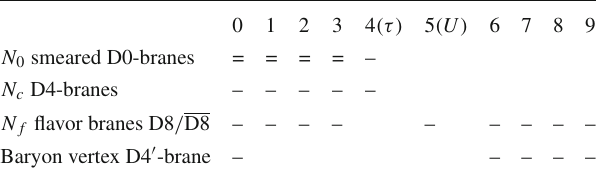
Table 1 The D-brane configurations: “=” denotes the smeared direc- tions, “-” denotes the world volume